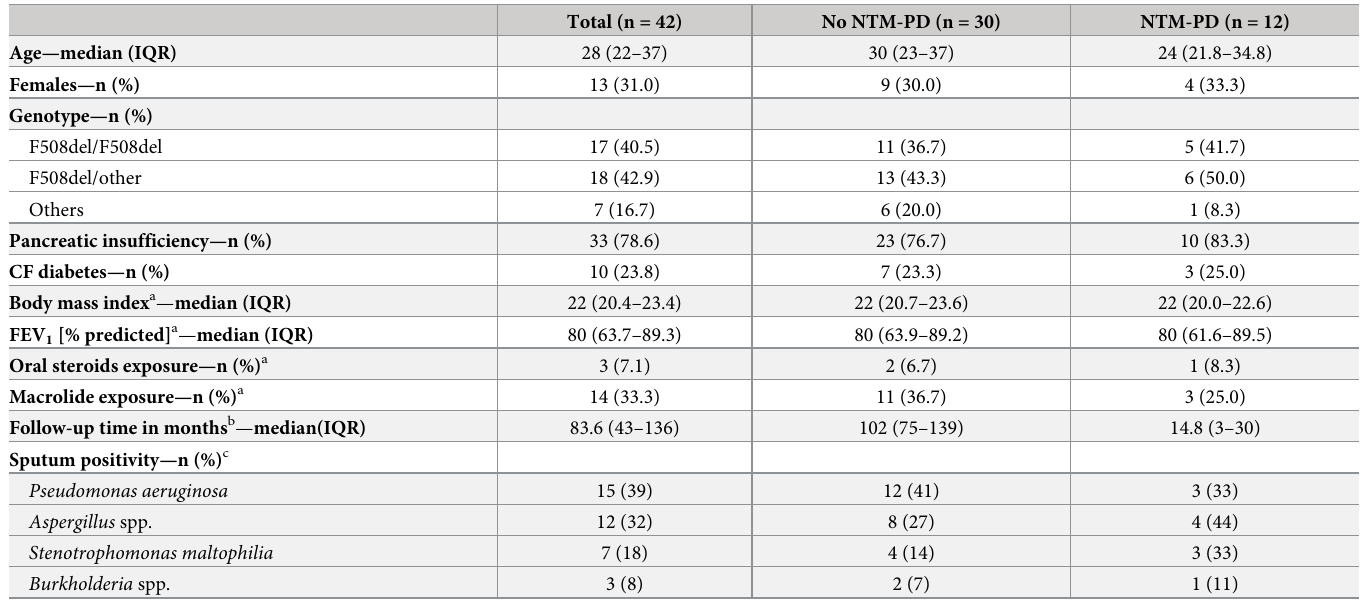
Table 1. Demographic and clinical characteristics of included patients at baseline, stratified by NTM-PD status.